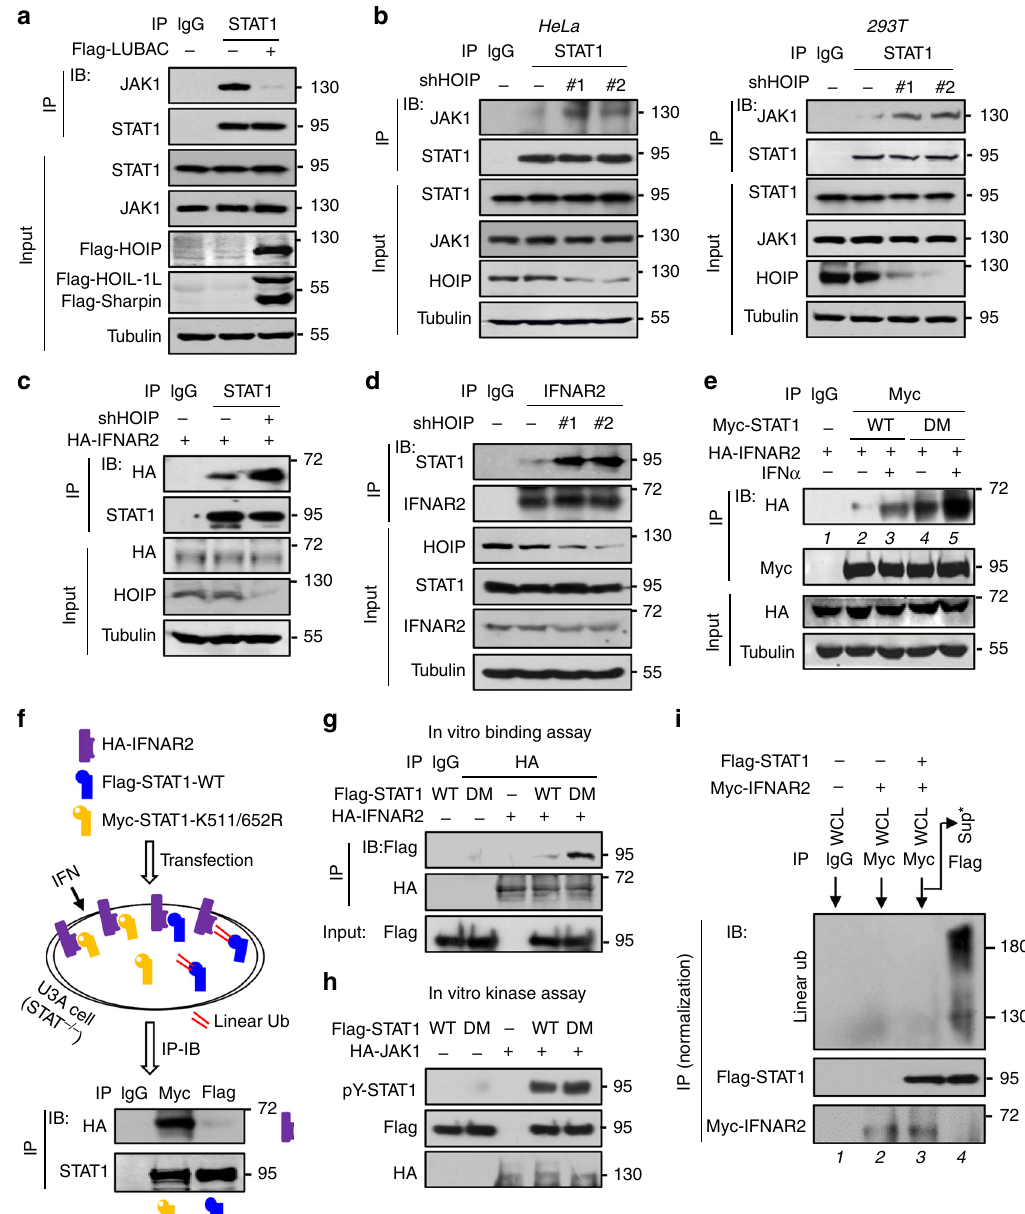
Fig. 4 Linear ubiquitination blocks the binding of STAT1 to IFNAR2. a Immunoprecipitation analysis of the interaction between endogenous JAK1 and STAT1 in HEK293T cells transfected with or without Flag-LUBAC and then treated with IFN α (1000 IU/ml) for 15 min. b Immunoprecipitation analysis of the interaction between endogenous JAK1 and STAT1 in HeLa (left) and HEK293T (right) cells transfected with shHOIP (#1, #2) and then treated with IFN α as a . c Immunoprecipitation analysis of the interaction between HA-IFNAR2 and endogenous STAT1 in HEK293T cells transfected with shHOIP and then treated with IFN α as a . d Immunoprecipitation analysis of the interaction between endogenous IFNAR2 and STAT1 in HEK293T cells treated as b . e Immunoprecipitation analysis of the interaction between HA-IFNAR2 and Myc-STAT1 in HEK293T cells cotransfected with HA-IFNAR2 and Myc-STAT1- WT or Myc-STAT1-K511/652R (DM) and then treated with IFN α as a . f Immunoprecipitation analysis of the interaction between HA-IFNAR2 and STAT1 (WT or DM) in a plate of U3A cells cotransfected with HA-IFNAR2 (purple rectangle), Flag-STAT1-WT (blue rectangle), and Myc-STAT1-DM (orange rectangle) and then treated with IFN α as a . Double red lines: linear ubiquitination. g In vitro binding assay to analyze the interaction between HA-IFNAR2 and Flag-STAT1 (WT or DM) that were immunoprecipitated from HEK293T cells transfected with either HA-IFNAR2 or Flag-STAT1. h In vitro kinase assay to analyze the phosphorylation effect of HA-JAK1 on Flag-STAT1 (WT or DM). i HEK293T cells were transfected with Myc-IFNAR2 and (or) Flag-STAT1. The Flag-STAT1 proteins binding with Myc-IFNAR2 were immunoprecipitated by Myc antibodies. The supernatant from Myc immunoprecipitation was subjected to further immunoprecipitation using Flag antibodies to pull down those Flag-STAT1 proteins that did not interact with Myc-IFNAR2. Linear ubiquitination was analyzed as indicated. Data are representative of three independent